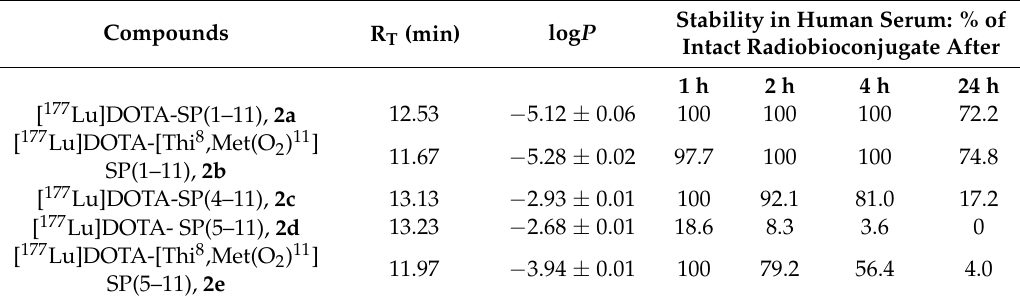
Table 2. Physico-chemical properties of [ 177 Lu]DOTA-SP radiobioconjugates (R T values were determined using HPLC (system